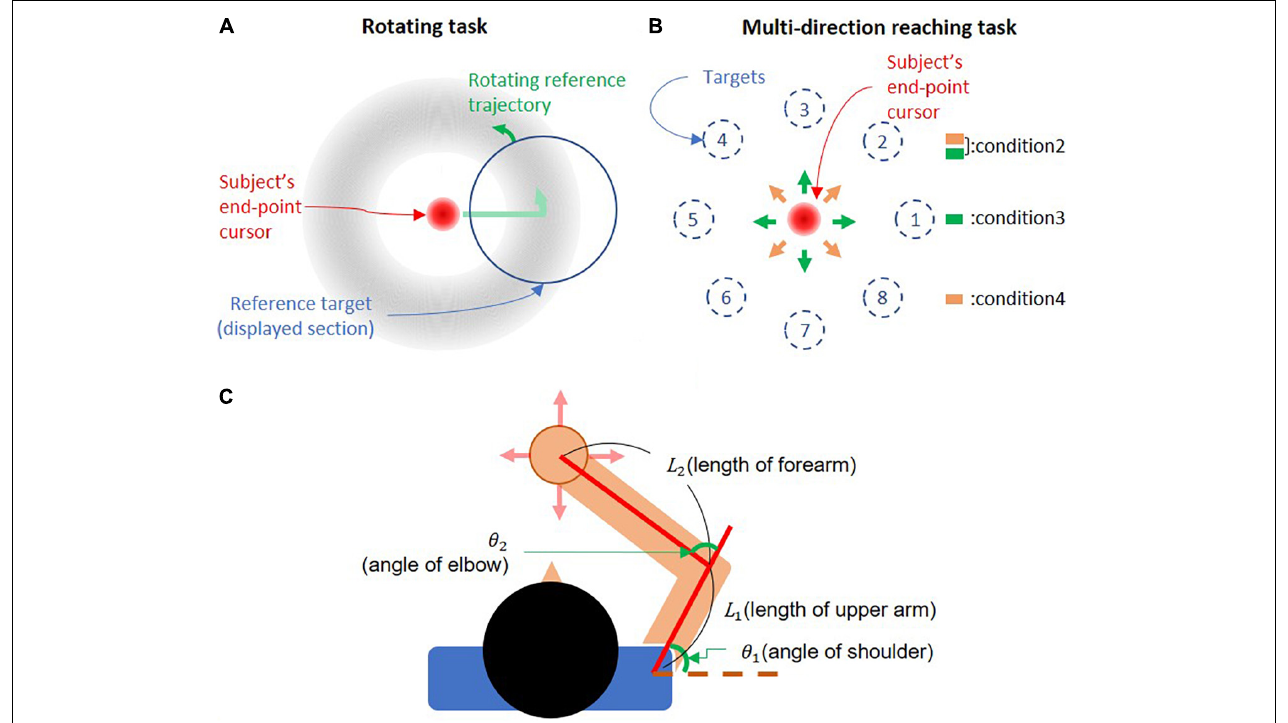
FIGURE 1 | Experimental setup. (A) Rotating task. The cursor is controlled by the subject’s end-point force. Subjects move the cursor around a circular trajectory indicated by a doughnut-shaped silhouette. Only a portion of the silhouette enclosed by the reference target is visible during the task. The reference target rotates around the trajectory, setting the pace at which subjects move the cursor. (B) Multidirection reaching task. The cursor is controlled by the subject’s end-point force, and targets are presented according to the trial condition (direction and force level). Subjects were instructed to move the cursor to target. (C) Subject’s arm posture. The upper arm was set between 40 ◦ and 70 ◦ with respect to the frontal axis. The forearm was fixed to the handle, so that it formed an angle between 65 ◦ and 90 ◦ with the upper arm.